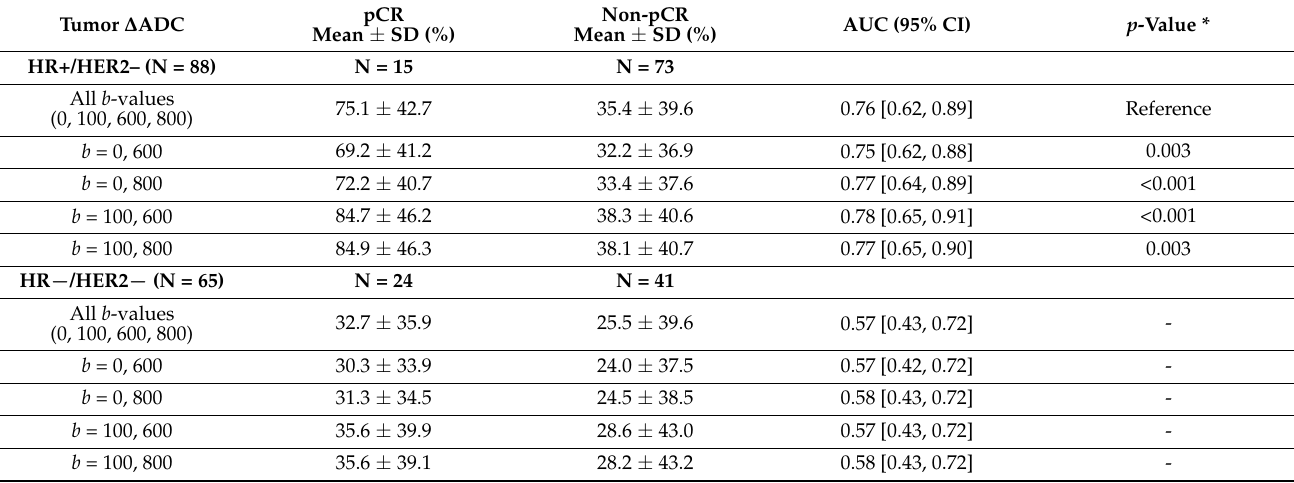
Table 4. Relative performance of two- versus four- b -value ADC calculations for predicting pCR stratified by cancer subtype.